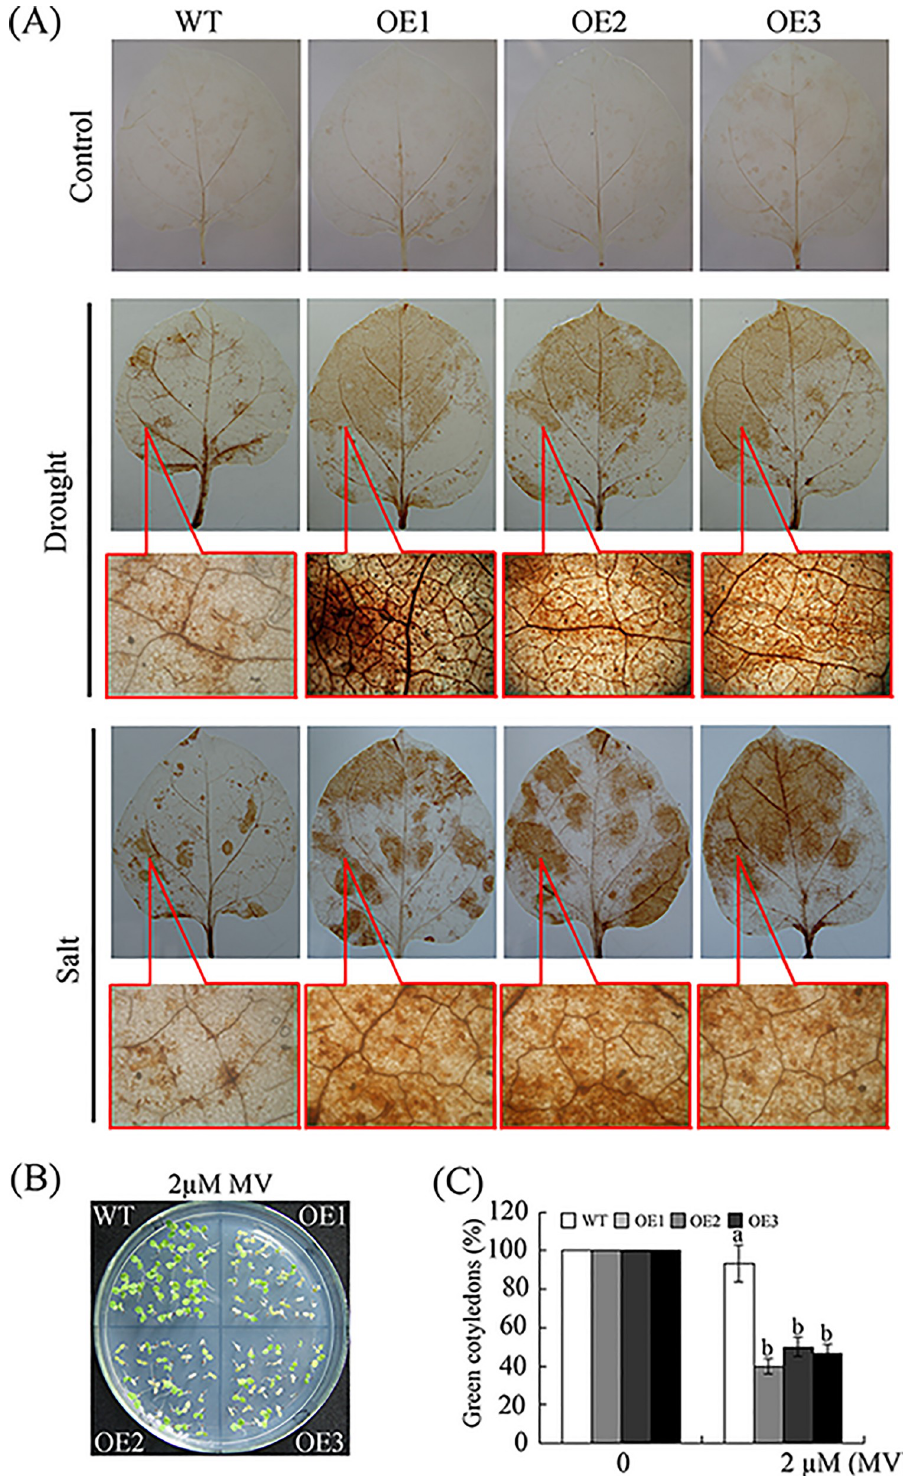
Fig 9. The constitutive expression of GhWRKY68 increased ROS production and oxidative damage in transgenic plants. (A) Representative photographs of H 2 O 2 accumulation using DAB staining. For drought and